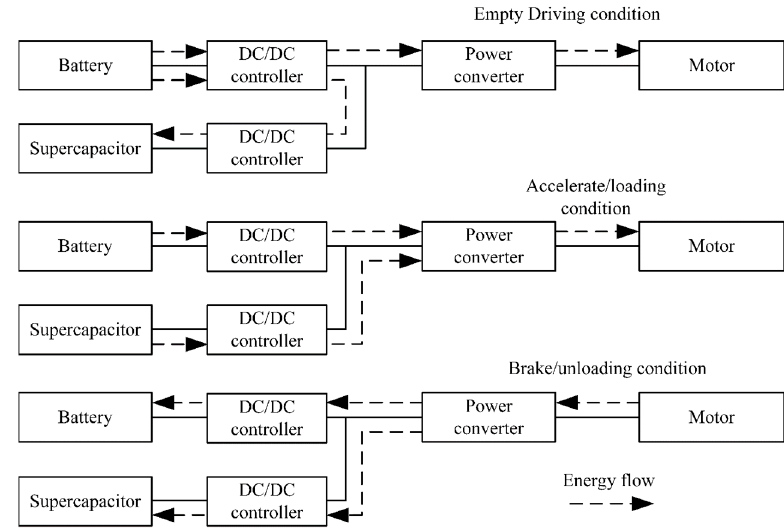
Figure 5. The energy fl ow direction of the HES.